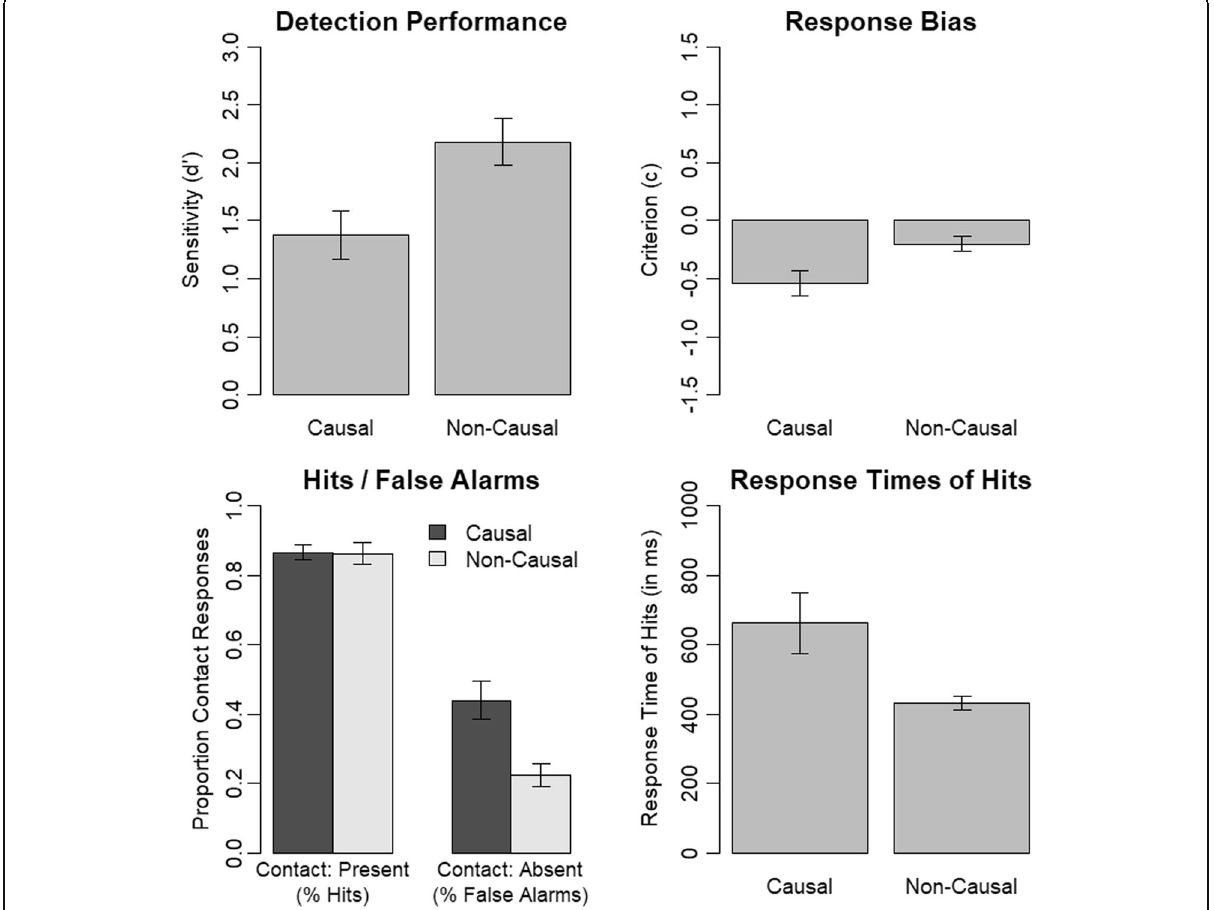
Fig. 2 Results of Experiment 1 (immediate-response experimental version). Error bars indicate the standard error of the